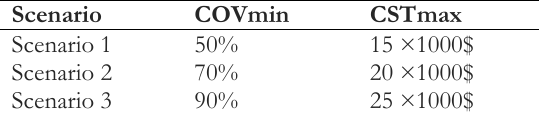
Table 7. Different simulation